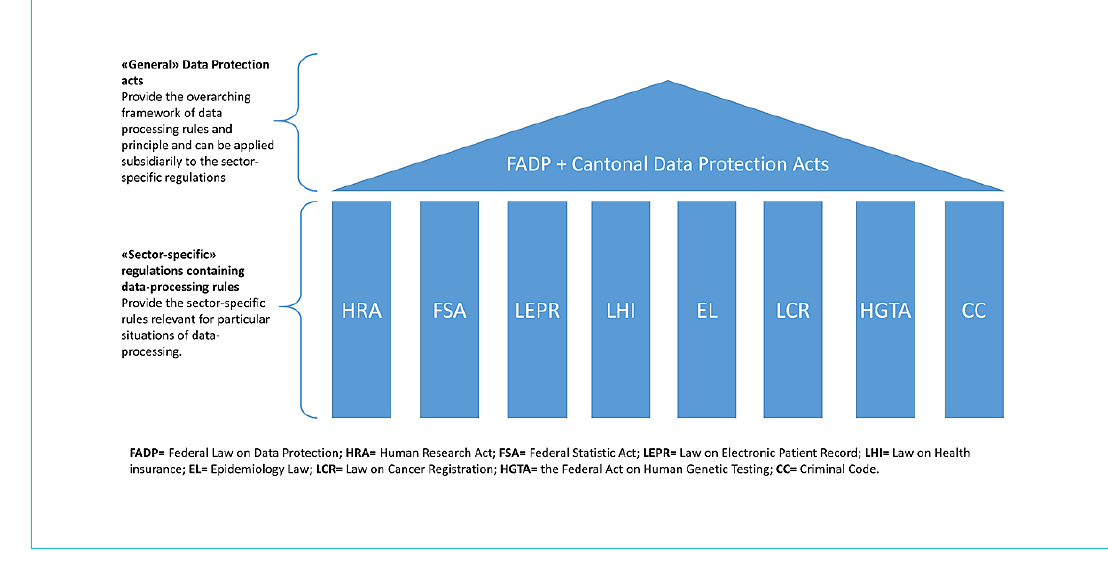
Figure 2: An overview of parts of the legislative framework concerning data processing in Switzerland. The image does not aim to be exhaus- tive, but merely indicative of the relationship between different legislative acts concerning data protection and data processing in the health- care